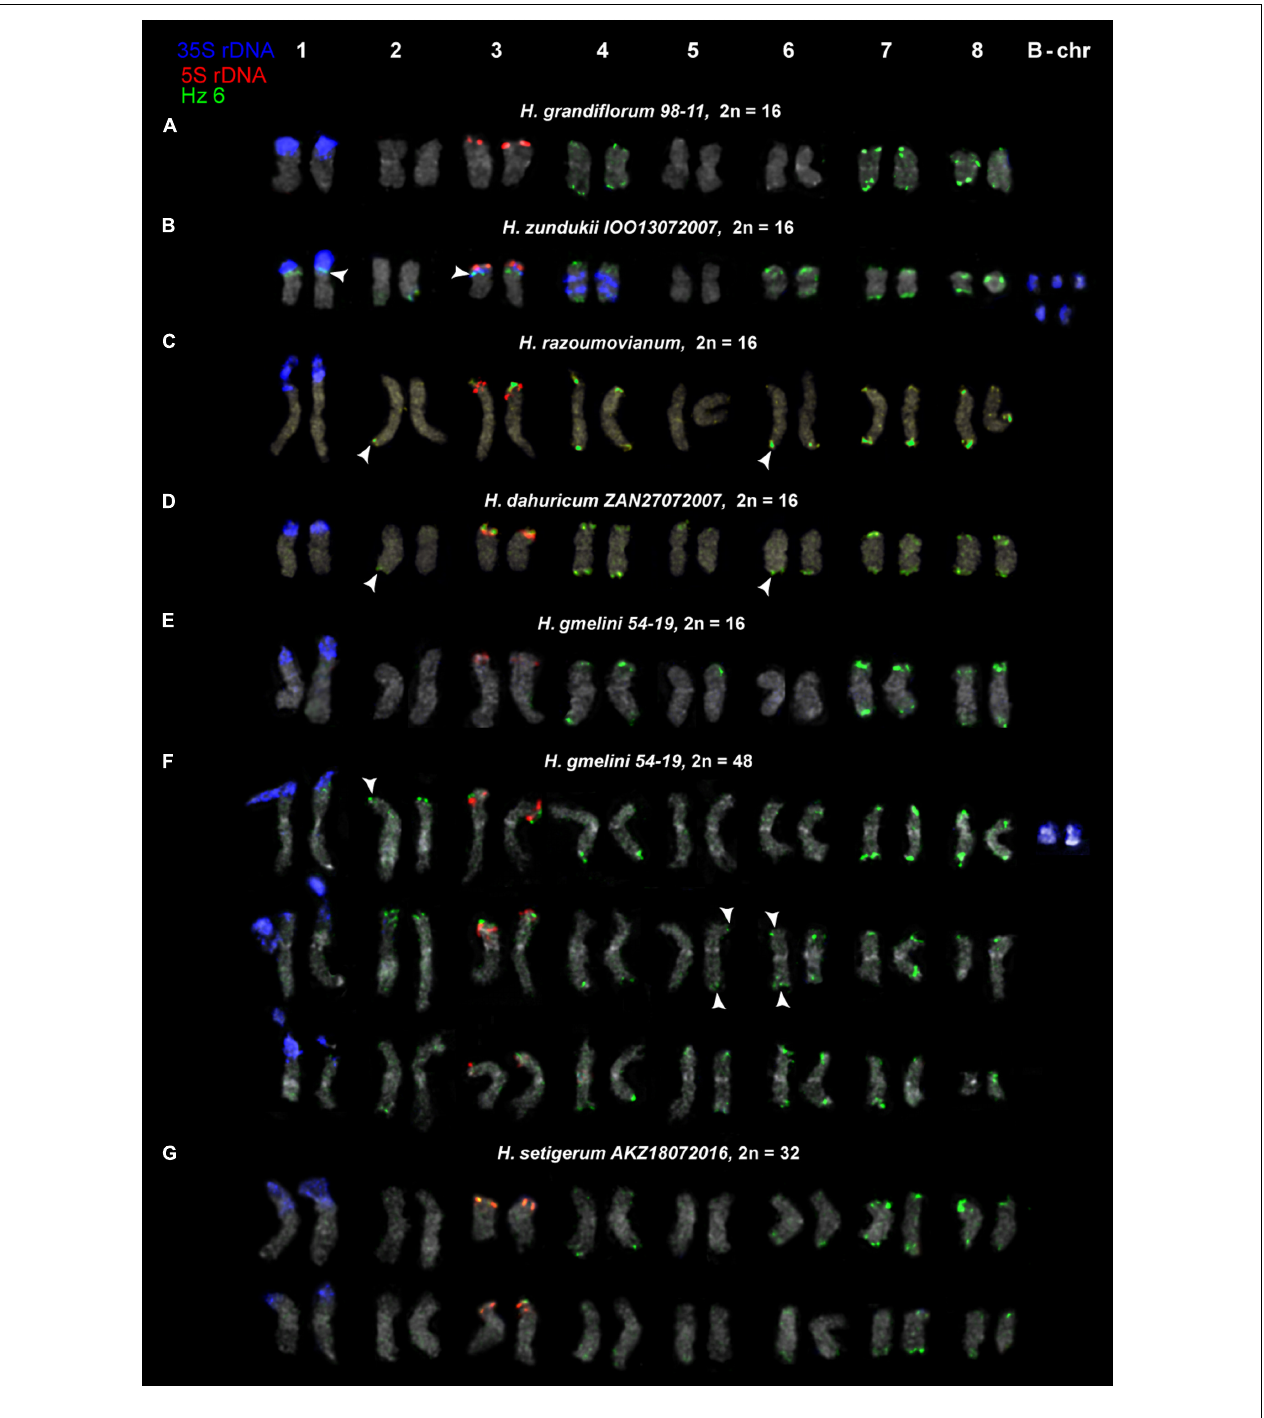
FIGURE 8 | Karyotypes of the studied accessions of H. grandiflorum (A) , H. zundukii (B) , H. razoumovianum (C) , H. dahuricum (D) , H. gmelinii (E,F) , and H. setigerum (G) after FISH with 5S rDNA, 35S rDNA and satellite repeat Hz 6 (the same metaphase plates as in Figures 3 , 4 ). Heads of arrows point to polymorphic sites of Hz 6. The correspondent probes and their pseudocolors are specified on the left.